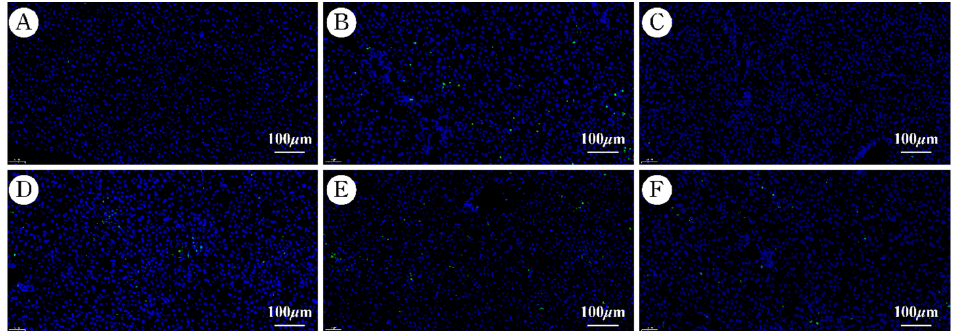
Figure 7. Effects of AaEA-mitigated liver cell apoptosis (magnification: ×20). ( A − F ) represent the control, ConA, DIG, AaEA-L, AaEA-M, and AaEA-H groups, respectively.